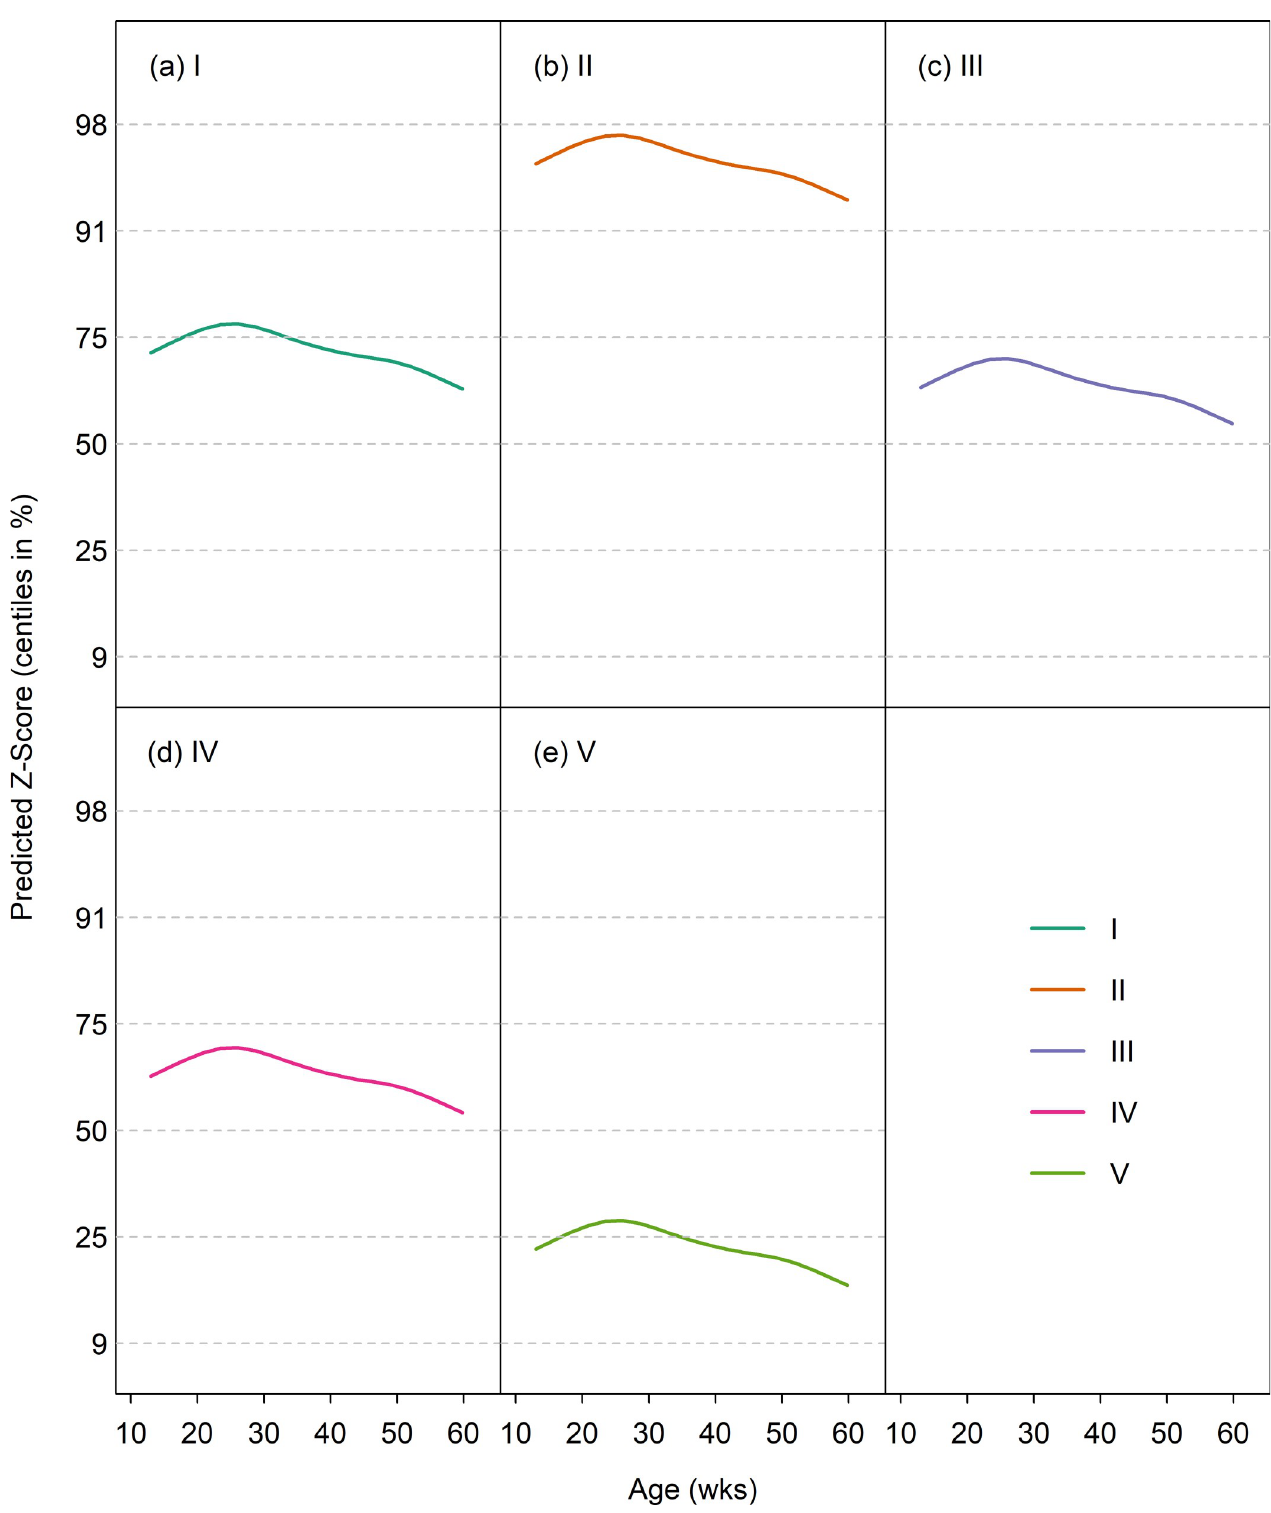
Fig 4. Median weight by age (on the centile scale) for the WALTHAM Research Colony dataset in 5 size classes. On each graph, the median for the validation dataset is depicted by the solid line, whilst the growth standard centiles are indicated by dotted horizontal lines.